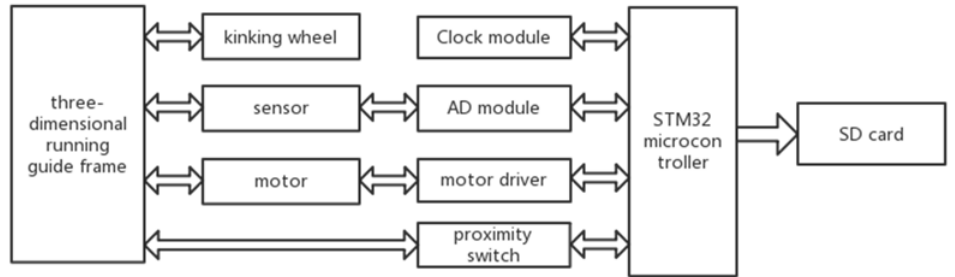
Figure 2. Diagram of the system design .